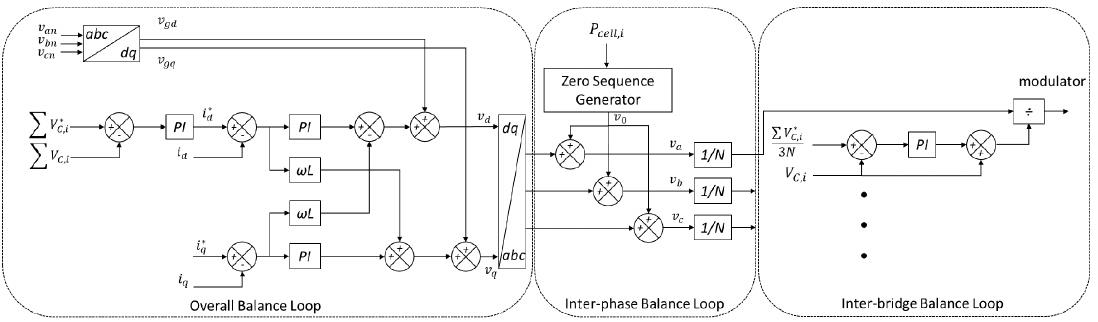
Figure 2. VOC control with zero-sequence vector injection for a generic CHB grid-tied